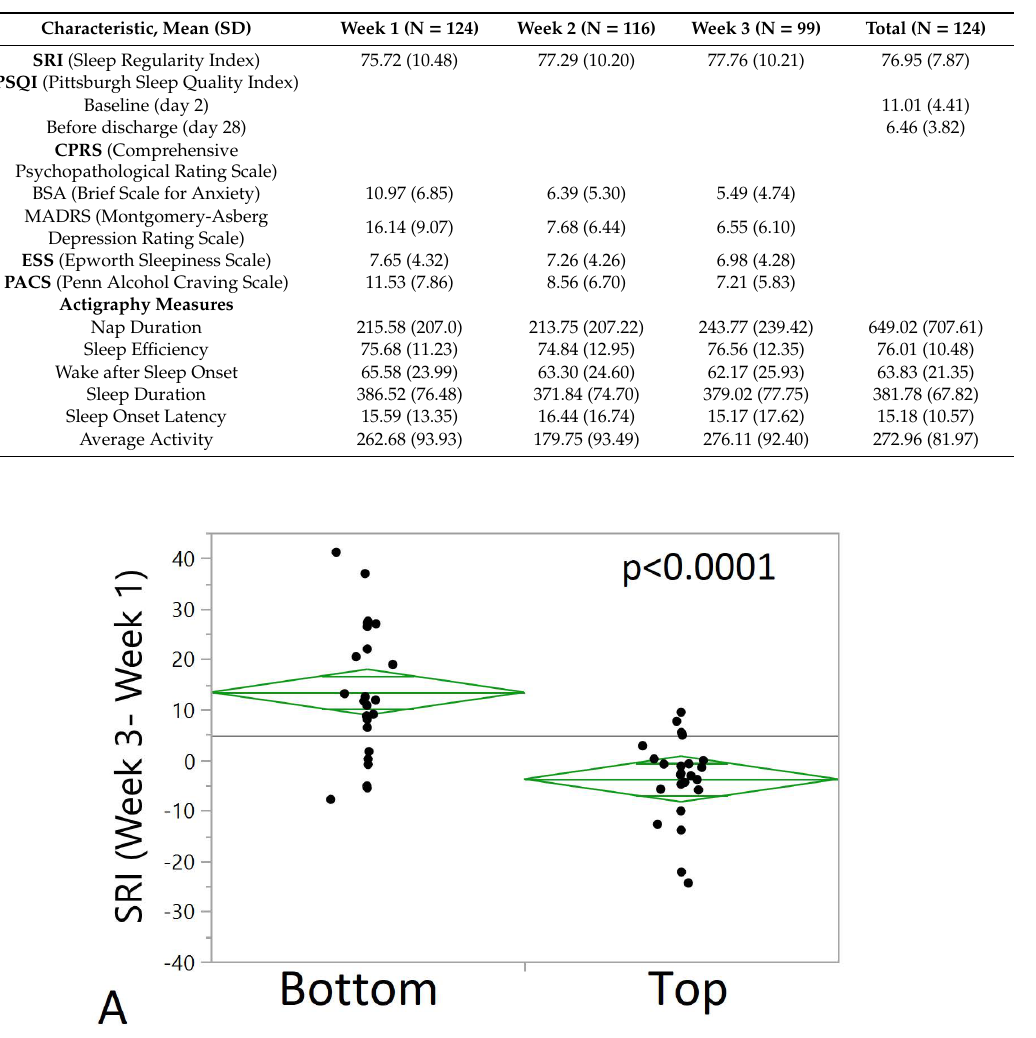
Table 2. Distribution of sleep and clinical variables during the inpatient stay.